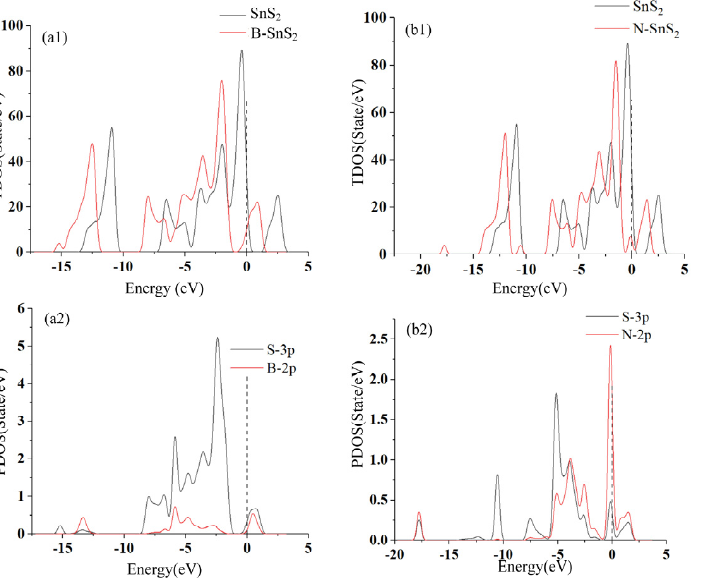
Figure 2. ( a1 ) TDOS of SnS 2 and B-SnS 2 , ( b1 ) TDOS of SnS 2 and N-SnS 2 , ( a2 ) PDOS of B-SnS 2 , ( b2 ) PDOS of N-SnS 2 .